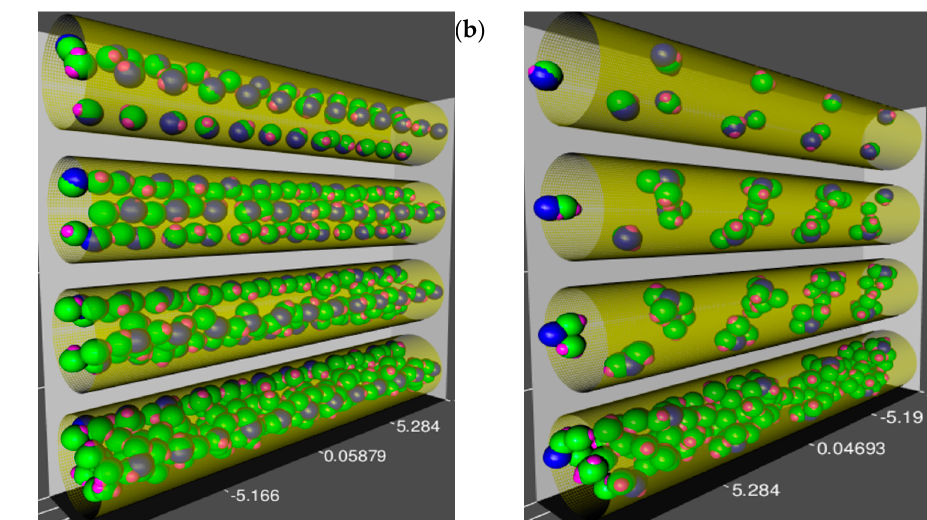
8 of 13 Figure 7. Snapshot showing a monolayer formed on a 0.95 nm pore at 25 °C with strengthened wall-water interaction: ( a ) side view and ( b ) front view. Each green ball with two attached magenta balls represents a water molecule. 3.6. Water Clusters Hysteresis disappeared when ε H increased to 22.5 kcal/mol (Figures 5b and 6b), and in contrast to abrupt micropore fillings observed in earlier scenarios, a gradual increase of adsorbed water molecules driven by the formation of clusters initiated at the positions of sorption sites was observed. Figure 8 shows snapshots of simulated 0.95 nm pores at a series of given H values: 0.000036%, 0.00050%, 0.16%, 0.35% for PW 1 and 0.000036%, 0.60%, 5.57%, 6.34% for PW 2 . For both pore types, the water clusters were initiated at the sorption sites (indicated in blue balls in Figure 8), and then grew bigger, eventually coa- lescing as H increased. However, the water clusters only existed at very low H values (<0.35%) for PW 1 and slightly higher H values (6.34%) for PW 2 . Since PW 2 has weaker WWIS, the simulation results demonstrated that the less-hydrophilic cell wall pore sur- faces benefited the stabilization of the formed water clusters. The sorption process in this special case could be used to examine the situation described by clustering theory mainly developed by Hartley and Kamke and Hartley and Avramidis [5,6]. Accordingly, one wa- ter molecule was attached to each sorption site at a low H region (0–30%), and then as H increased, water clusters with an average size of two formed and grew larger. The pre-